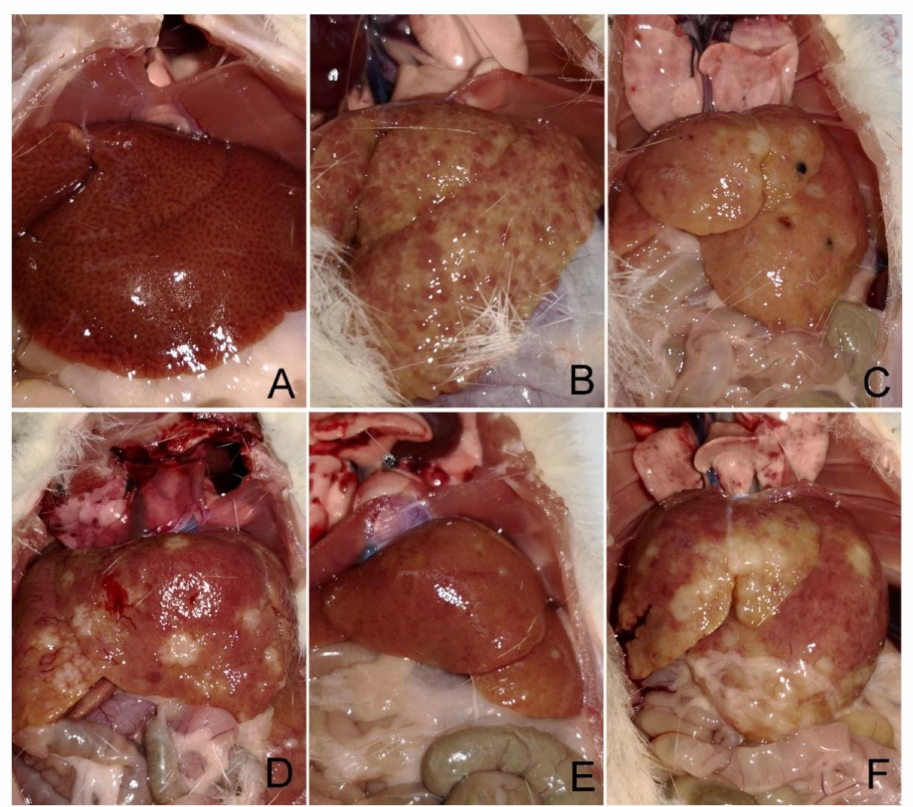
Figure 2. Representative photographs of liver appearances during the organ isolation in control, and rats treated with thioacetamide (TAA), thioacetamide + virgin olive oil (TAA+O), thioacetamide + C60 fullerene lower dose (TAA+F1), and thioacetamide + C60 fullerene higher dose (TAA+F2). ( A ) the liver of rats from the control group; ( B , C ) the liver of rats from the TAA group; ( D ) the liver of rats from the TAA+O group; ( E ) the liver of rats from TAA+F1 group; ( F ) the liver of rats from TAA+F2